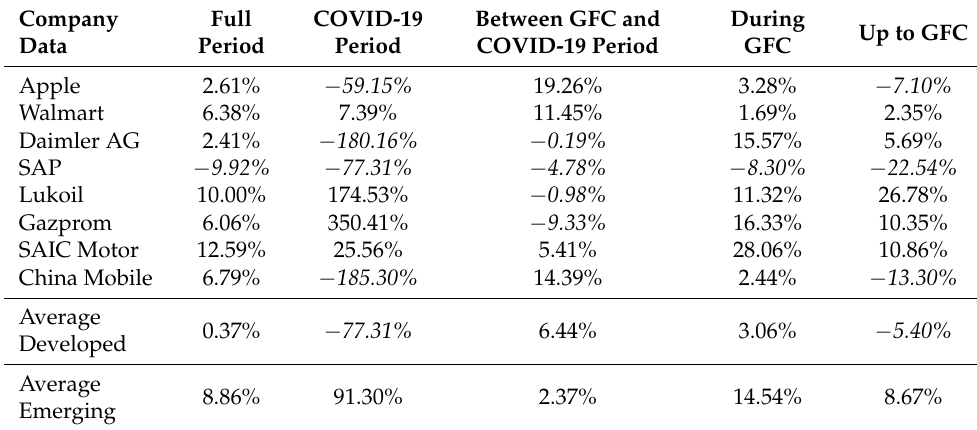
Table 7. Fama French five-factor model—results of cost of equity calculations for developed and emerging companies; negative values in italics.